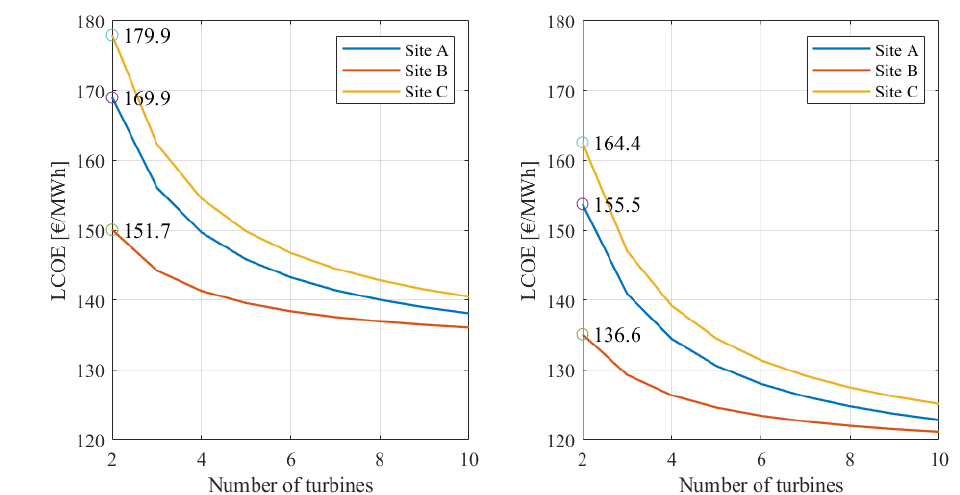
Figure 20. Influence of number of turbines for sites A, B, and C for both